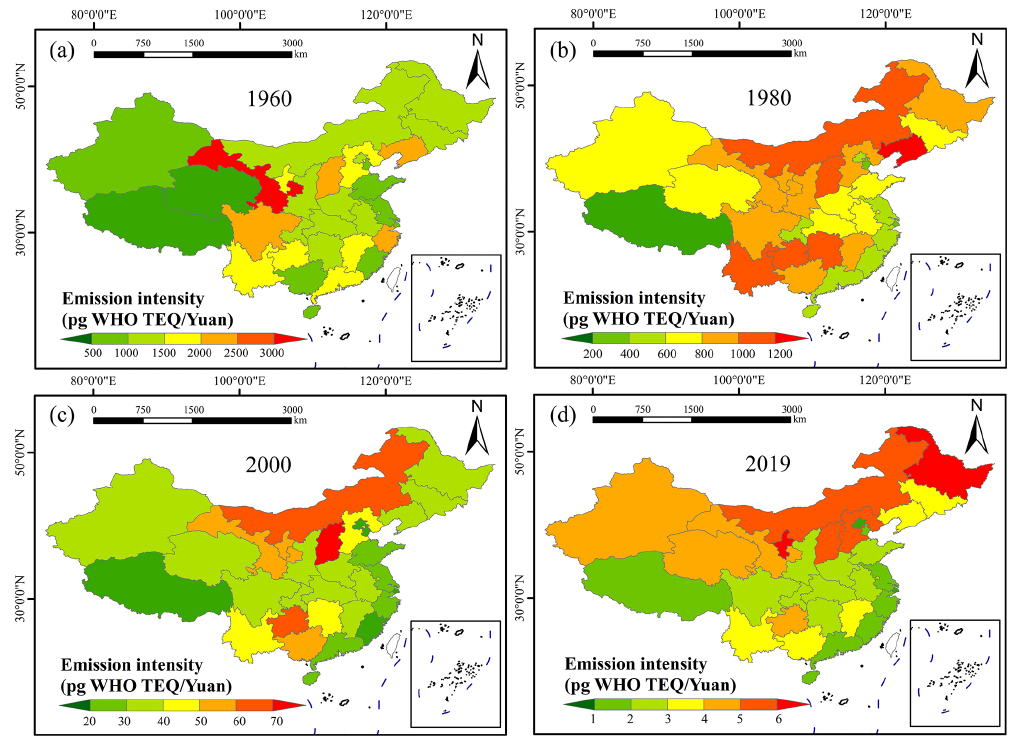
Figure 5. Emission intensities of UP-PCBs (pg WHO TEQ/yuan) across the Chinese mainland in the years 1960 (a) , 1980 (b) , 2000 (c) , and 2019 (d)